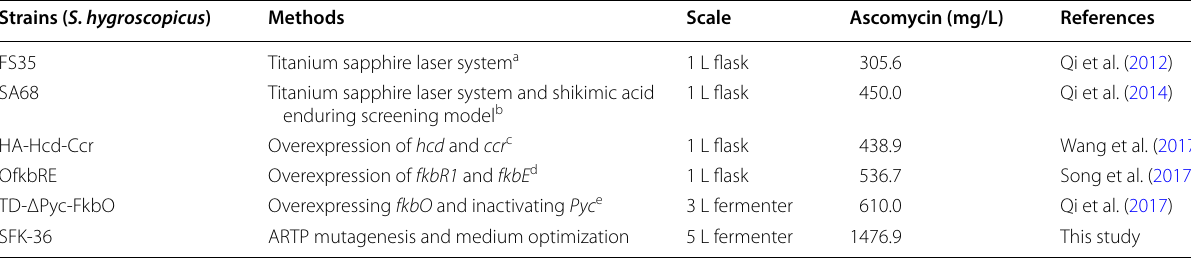
Table 4 Ascomycin production by different S. hygroscopicus